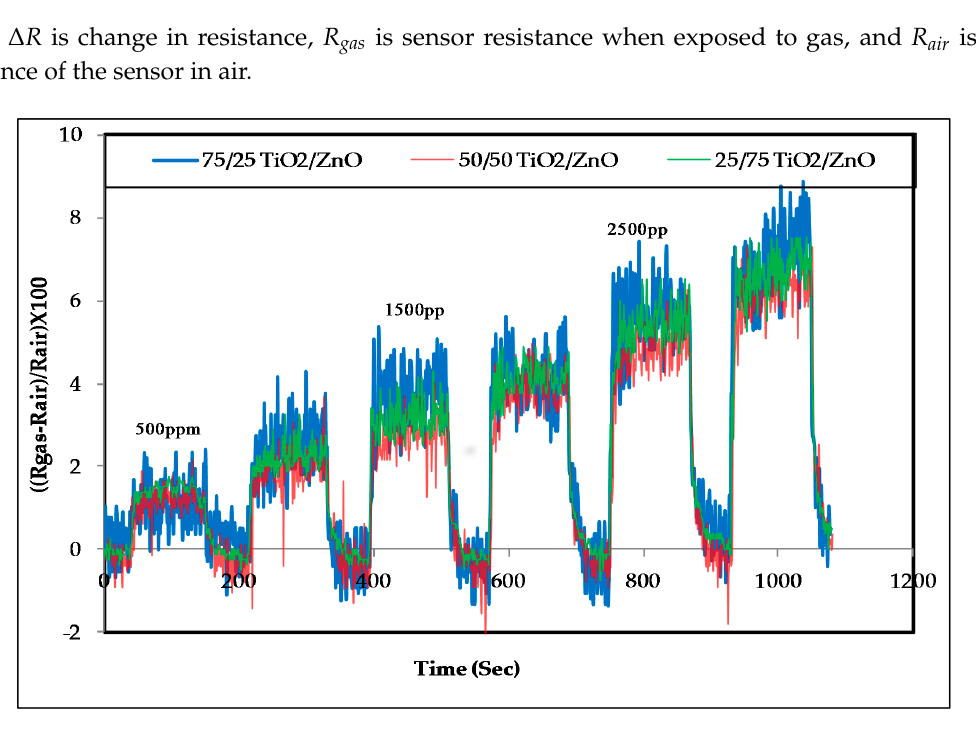
Figure 5. The response of the Zn 2 TiO 4 sensors to propanol at concentration range 500–3000 ppm increasing with a step size of 500 ppm at room